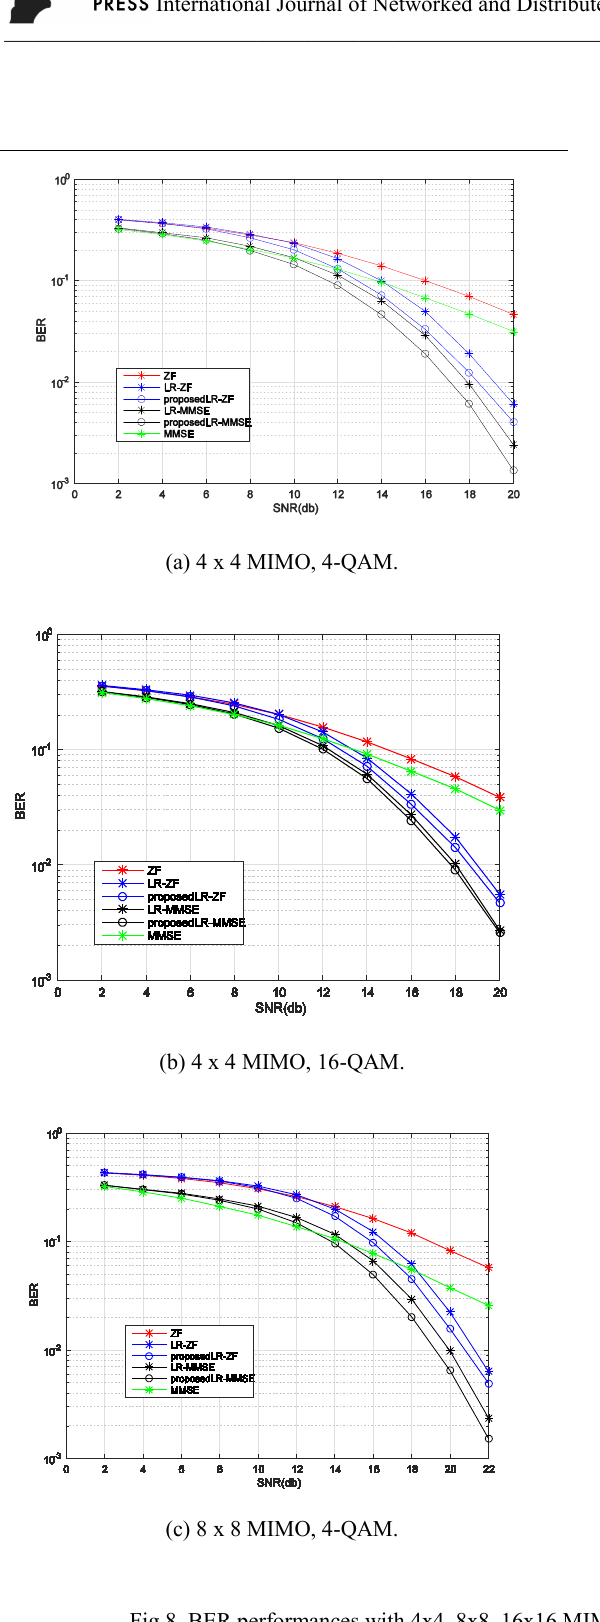
Fig.8. BER performances with 4x4, 8x8, 16x16 MIMO and 4, 16-QAM.Flowchart of proposed